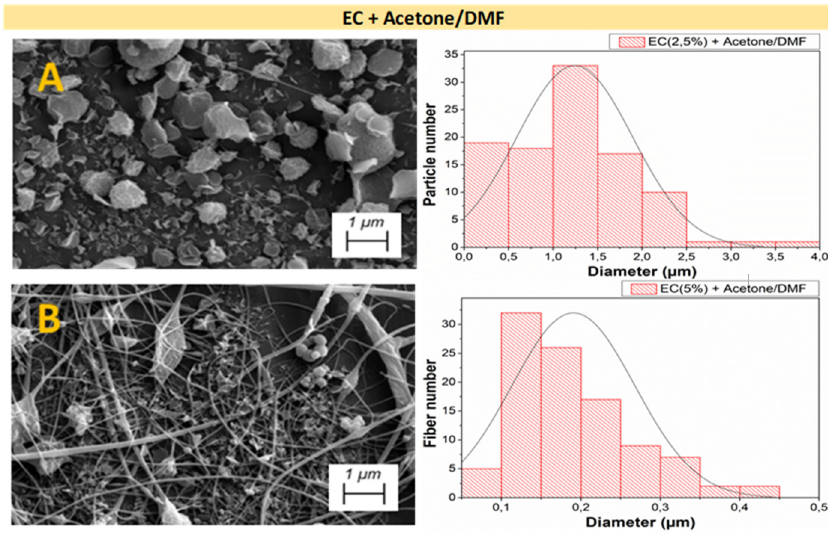
Figure 5. SEM images and distribution of microstructural properties of the nanostructures made with different EC concentrations ( A ) 2.5 wt.% and ( B ) 5 wt.%, using acetone and DMF as solvents.